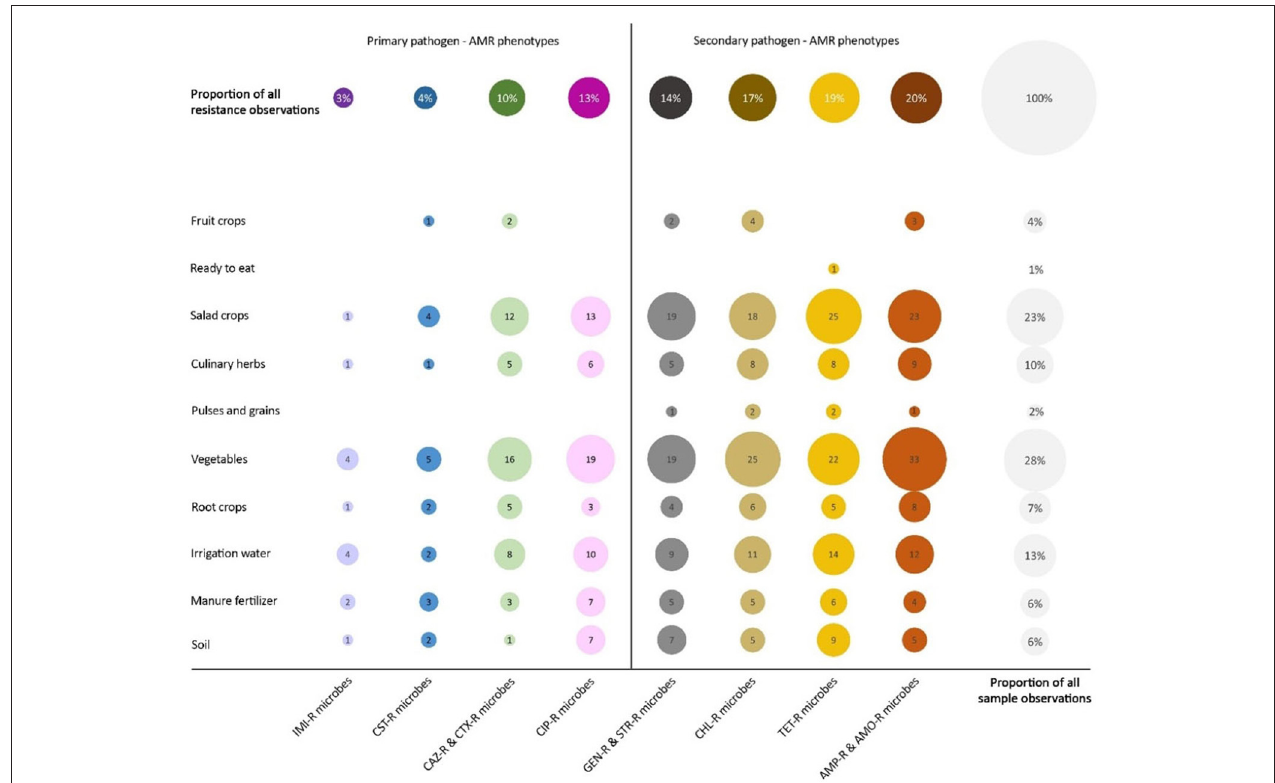
FIGURE 3 | Selected pathogen-AMR phenotype combinations detected in sample groups reported in studies published between 2000 and 2020. The number of AMR observations of primary and secondary pathogen-phenotype combinations are shown. IMI-R microbes: A . baumanii, E. coli , K. pneumoniae, Salmonella and Shigella spp.; CST-R microbes: E. coli , K. pneumoniae, Salmonella and Shigella spp.; CAZ-R and CTX-R microbes: E. coli , K. pneumoniae, Salmonella and Shigella spp.; CIP-R microbes: Salmonella spp ., E. coli and K. pneumoniae; GEN-R and STR-R microbes : E. coli, K. pneumoniae and S. aureus ; CHL-R microbes: E. coli , K. pneumoniae, Salmonella spp ., Shigella spp., S. aureus , E. faecium and E. faecalis; TET-R microbes : E. coli , K. pneumoniae, Salmonella spp ., Shigella spp., S. aureus and L. monocytogenes; AMP-R and AMO-R microbes: E. coli , K. pneumoniae, Salmonella spp ., Shigella spp., L. monocytogenes, E. faecium and E. faecalis. Circle size and central number indicate the aggregate number of observations corresponding to each pathogen-phenotype combination distributed across sample groups per study. The uppermost row indicates the relative proportion of all AMR observations represented by each pathogen-phenotype category in the column directly beneath. The right-most column (uncoloured) represents the relative distribution of sample groups, irrespective of susceptibility testing